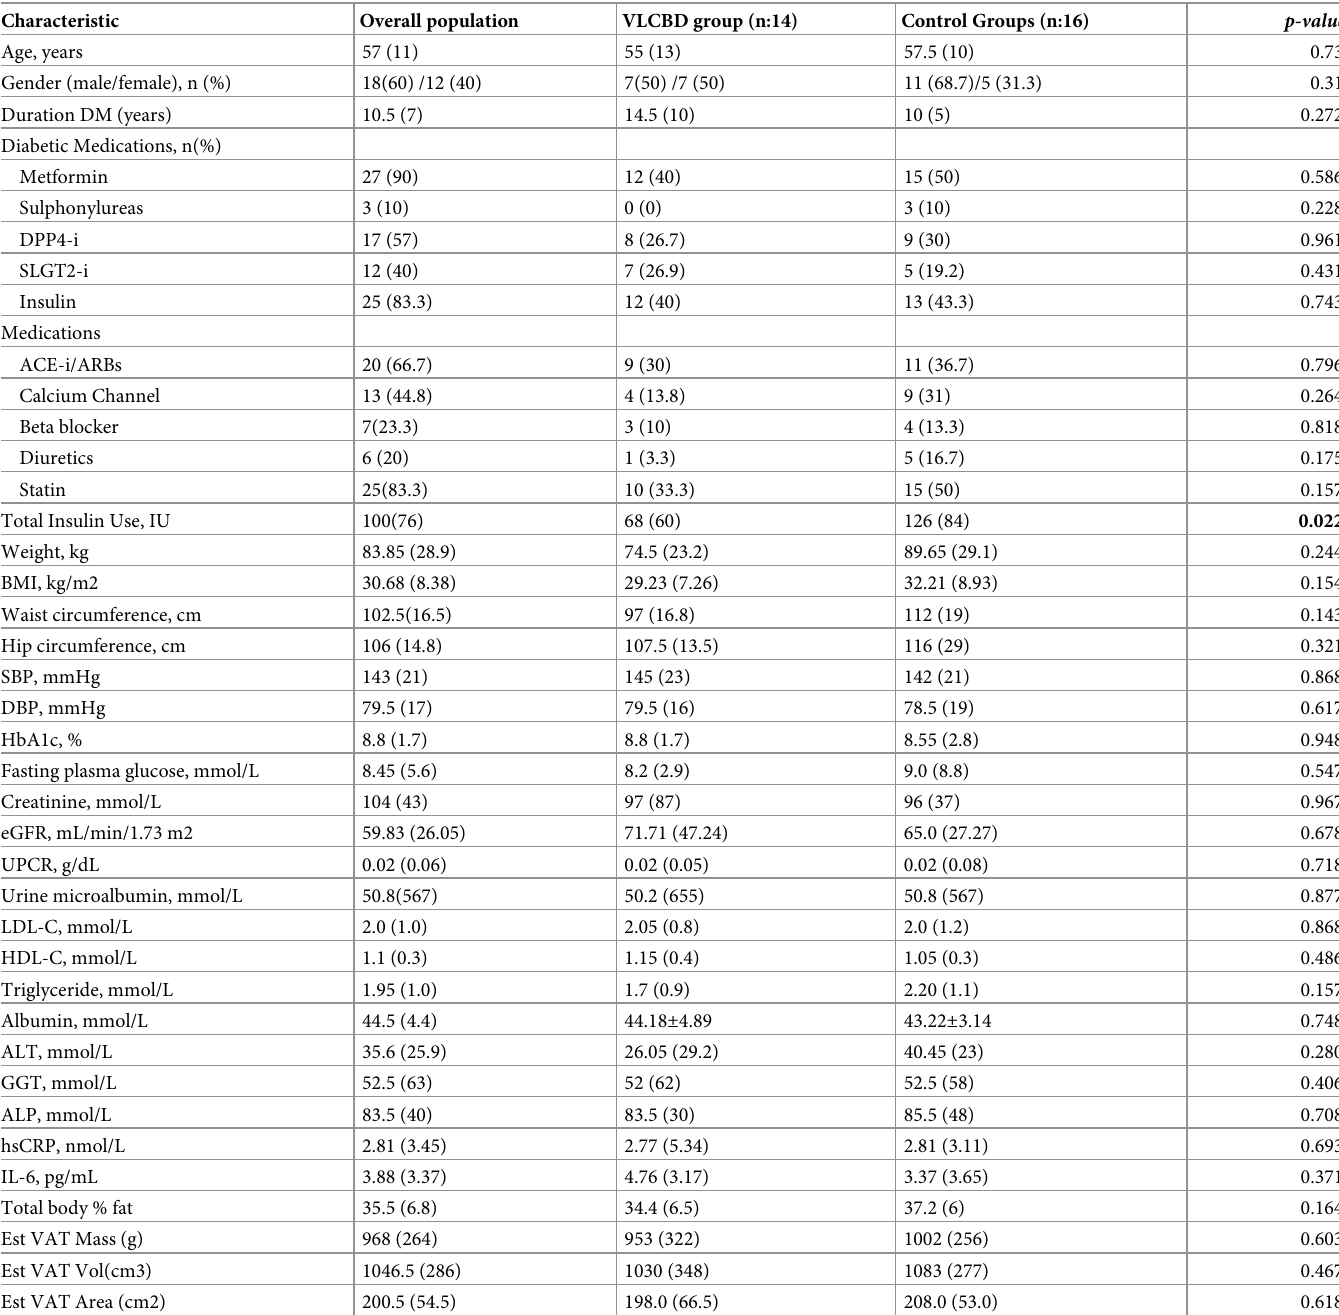
Table 1. Baseline demographic and clinical characteristics for whole populations (n = 30) and comparison between VLCBD and LPD groups.